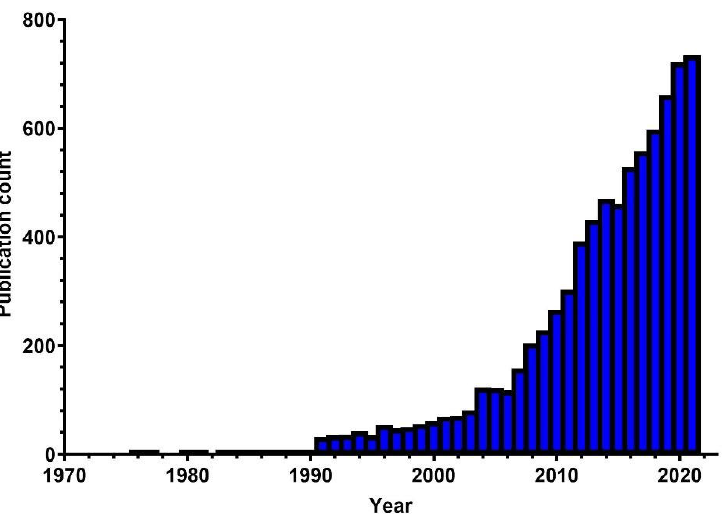
Figure 3. Number of original research articles on the impact of climate change on coral reefs published annually from 1977 until